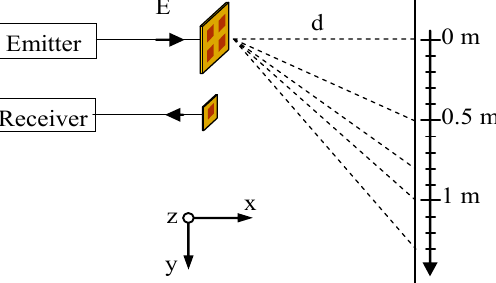
Figure 9. Experimental setup with the presence of two transponders with T 1 fixed in front of emitter and for T 2 position varying from y = 0.5 to 1.3 m.